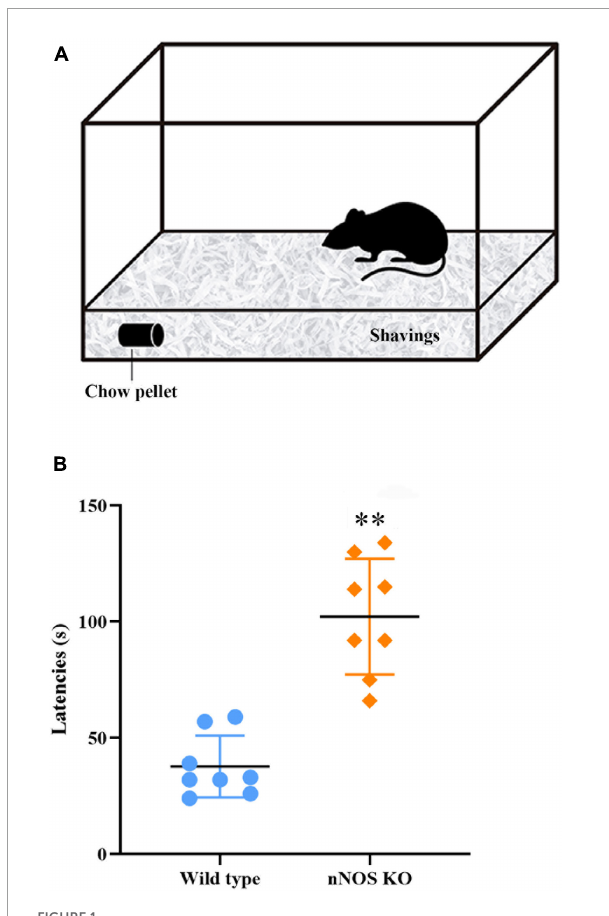
FIGURE1 Buried food test. (A) Schematic representation of the device employed. (B) Chart showing the delay, in seconds, in the time it takes for the mice to find the buried piece of food. It was observed that nNOS-KO mice took longer to find the buried food compared to wild-type mice, with highly significant differences between both experimental groups (nNOS KO 94.87 ± 35.05 s; wild type 45.12 ± 23.06 s; p = 0.007; ∗∗ p <